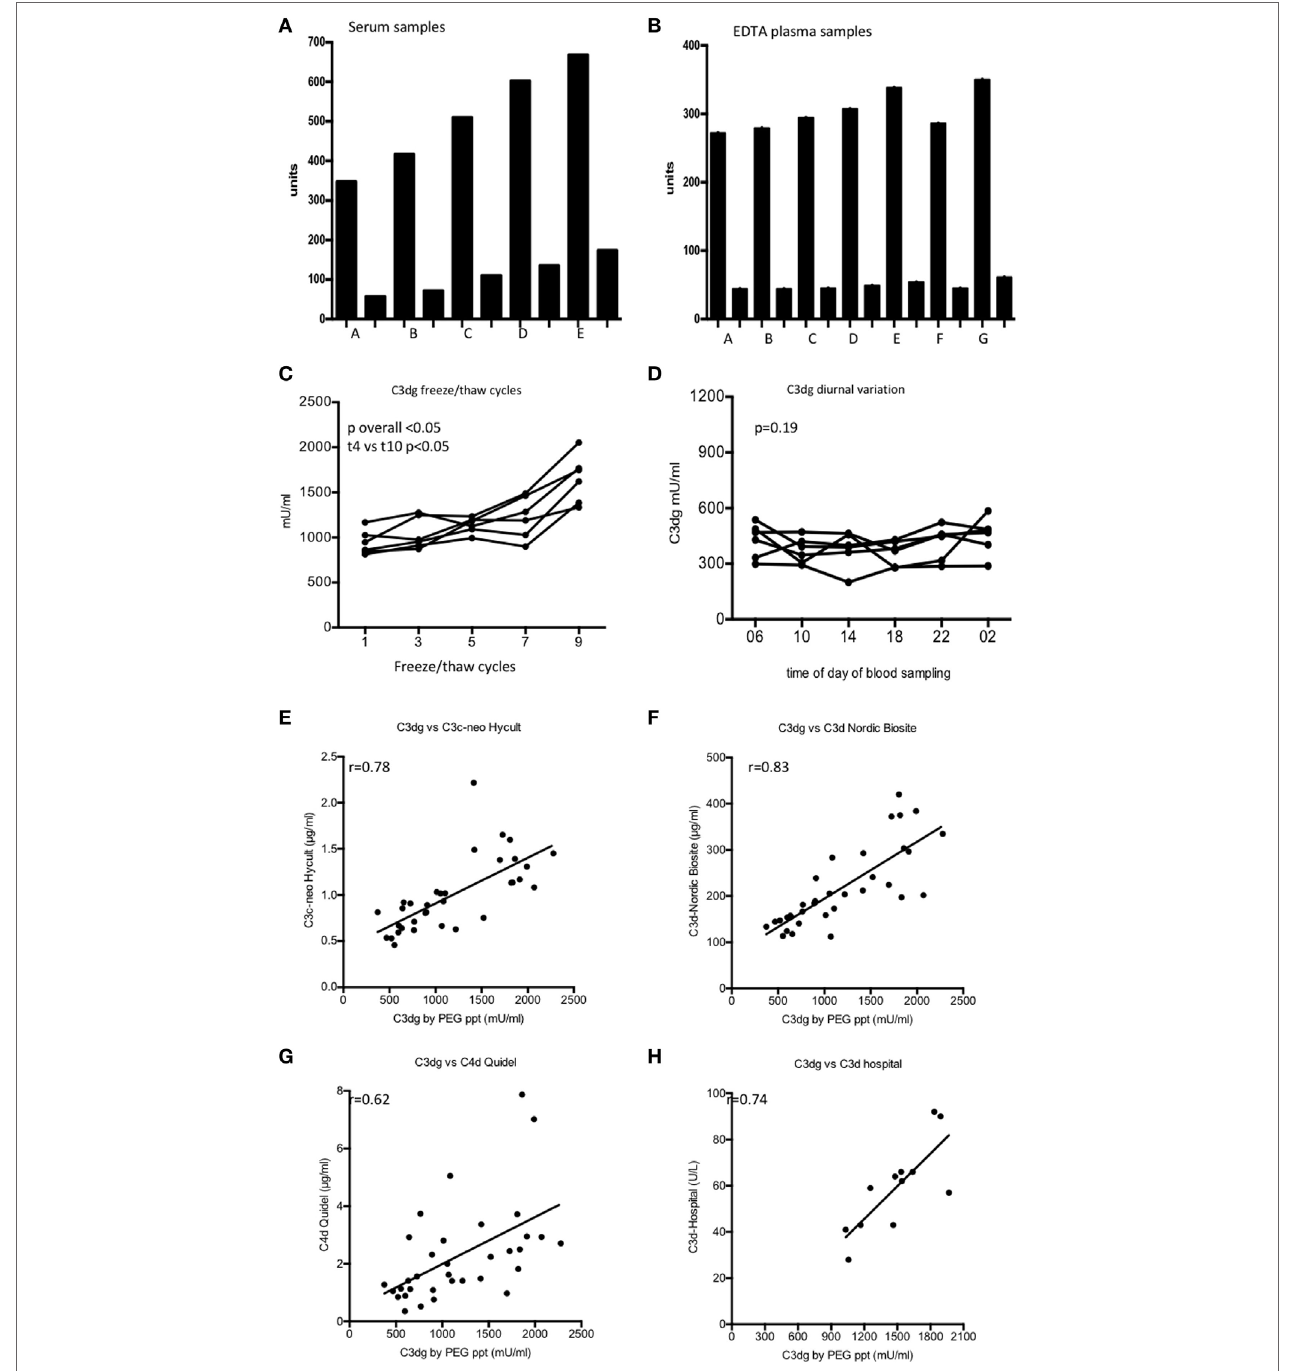
FigUre 2 | C3dg measured on samples handled in different ways from the time of blood withdrawal until measurement. (a) shows the result using serum and (B) shows the results using EDTA plasma. Each sample was diluted 100 (tall columns) and 1,000-fold (short columns). (a) Samples frozen t = 0, (B) samples frozen after 60 min at room temperature (RT), (c) samples frozen after 60 min at 37°C, (D) samples frozen t = 5 h at RT, (e) samples frozen t = 5 h 37°C, (F) EDTA plasma left 1 h at RT before centrifugation, (g) EDTA plasma left 5 h at RT before centrifugation. (c) The samples were tested for sensitivity to freeze/thaw cycles using six EDTA plasma samples. Samples were frozen up to 10 times each followed by thawing at RT for 1 h. C3dg was measured after 2nd, 4th, 6th, 8th, and 10th thawing. (D) C3dg diurnal variation. Six controls had blood drawn at six time points during 24 h, and C3dg was estimated. For comparison of the repeated measurements, the Kruskal–Wallis test was used. (e) Comparison between our assay and enzyme-linked immune sorbent assay (ELISA) kit from Hycult Biotech (C3c-neo determinants). (F) Comparison with ELISA kit from Nordic Biocite (C3d). (g) Comparison to ELISA kit from Quidel (C4d). 34 samples [17 systemic lupus erythematosus (SLE) and 17 controls] were analyzed in all kits. (h) Twelve randomly chosen SLE samples had C3d measured using the double rocket immuno- electrophoresis (19). The same samples were measured in our C3dg assay. To assess the correlation between the assays, Spearman correlation was